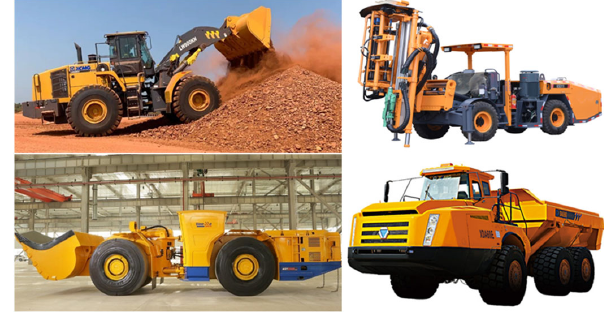
Figure 1. Typical applications of ASVs.